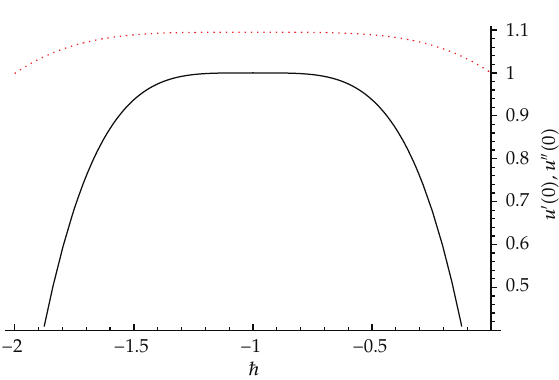
Figure 10: The (cid:2) -curves of u (cid:2) (cid:4) 0 (cid:5) and u (cid:2)(cid:2) (cid:4) 0 (cid:5) which are corresponding to the 5th-order approximate HAM solution of (cid:4) 4.13 (cid:5) and (cid:4) 4.14 (cid:5) . Dotted line: u (cid:2) (cid:4) 0 (cid:5) and solid line: u (cid:2)(cid:2) (cid:4) 0 (cid:5) .